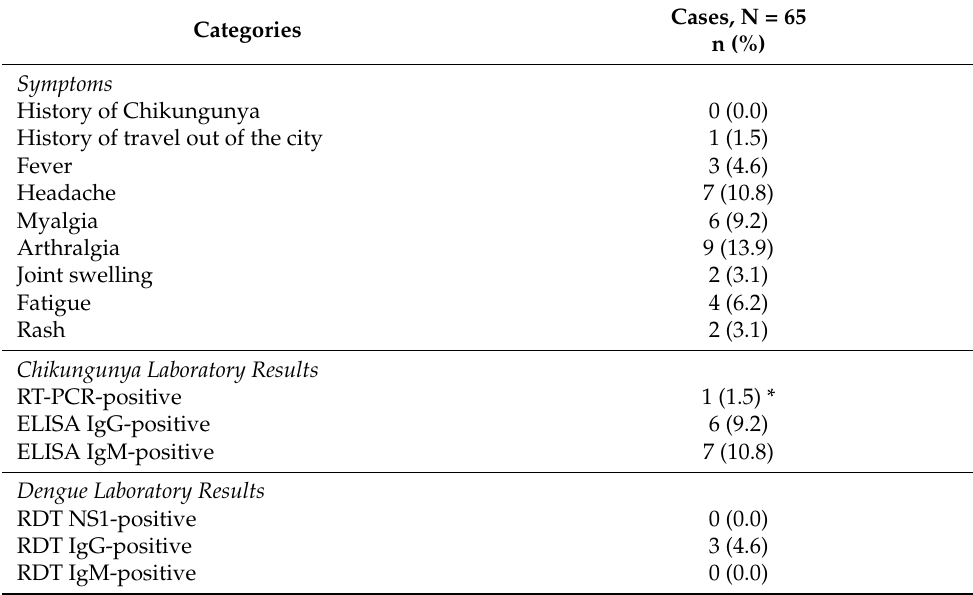
Table 1. Characteristics of samples used in the